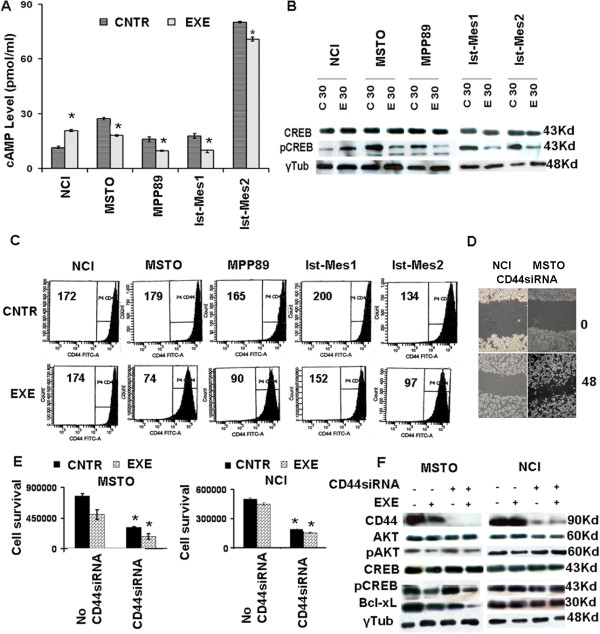
Exemestane acts in MPM cells by cAMP and CD44. A, cAMP ELISA detects a decrease in cAMP levels upon 35 μM exemestane treatment for 30 min (EXE), compared to untreated (CNTR), in all lines except NCI. B, western blot identifies CREB phosphorylation (pCREB) inhibition in cell lines responsive to exemestane treatment (E30) versus untreated (C30). C, flow cytometric characterizzazion of CD44 expression in untreated and treated MPM cell lines. Data are presented as a count of positive cells and numerical value indicates CD44 mean fluorescence intensity (MIF) of total cell population in the sample analyzed. Excluding NCI, all MPM cell lines show a reduction of MIF. D, siRNACD44 in MSTO and NCI reduced MPM cell lines migration in wound healing assay E, siRNA CD44 transfection resulted in decreased cell viability in MSTO and NCI cell lines compared to no CD44 siRNA. In addition, exemestane treatment further reduces the MSTO cell survival. No effect was observed in NCI. F, Western blot shows the silencing of CD44 occurring in MSTO and NCI. Moreover, the effect of exemestane in MSTO resulted in a decreased phosphorylation of AKT and CREB and in the reduction of Bcl-xL both in silenced cells that did not. No change was observed in NCI upon exemestane treatment both in silenced cells that did not. Graphs represent the average of at least 3 repeated experiments; *, statistically significant effects (P < 0.05).